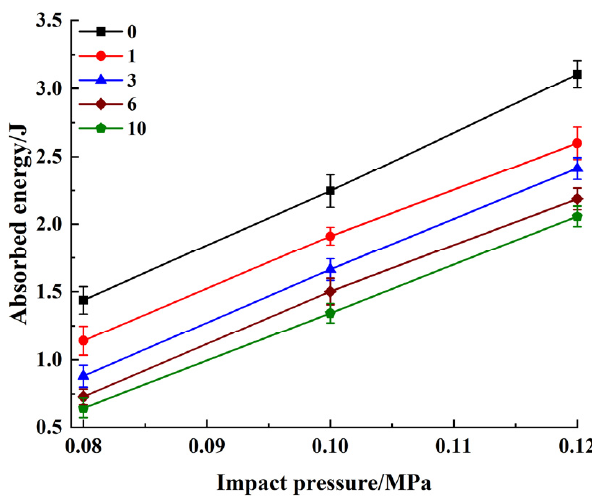
Figure 16. Effect of impact pressure on absorbed energy.